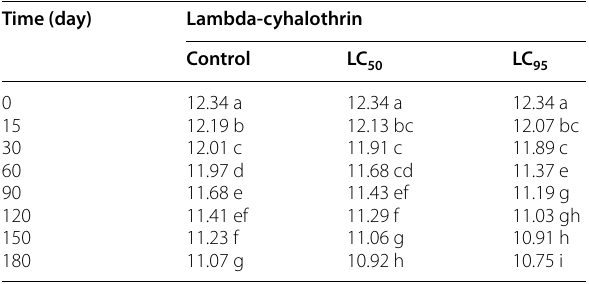
Table 5 Effect of basil and petitgrain mandarin oils on number of emerged progeny and reduction percentages of R. dominica